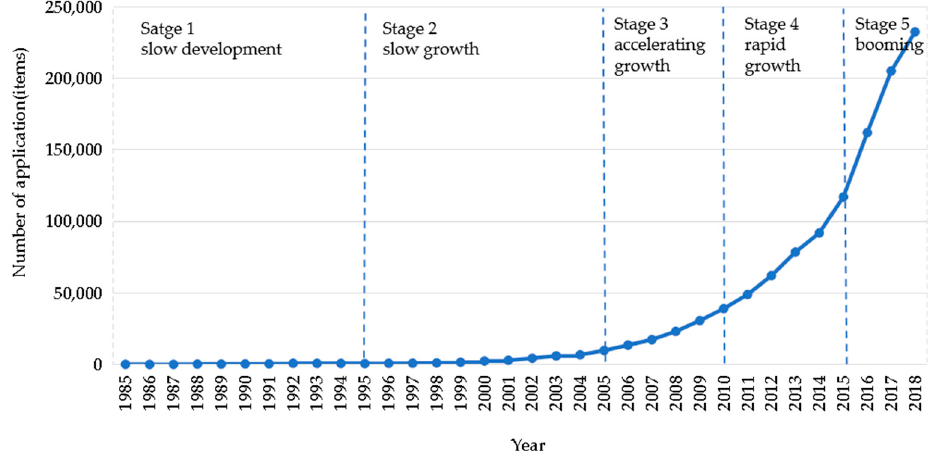
Figure 1. Number of green invention patent applications for the period 1985–2018.